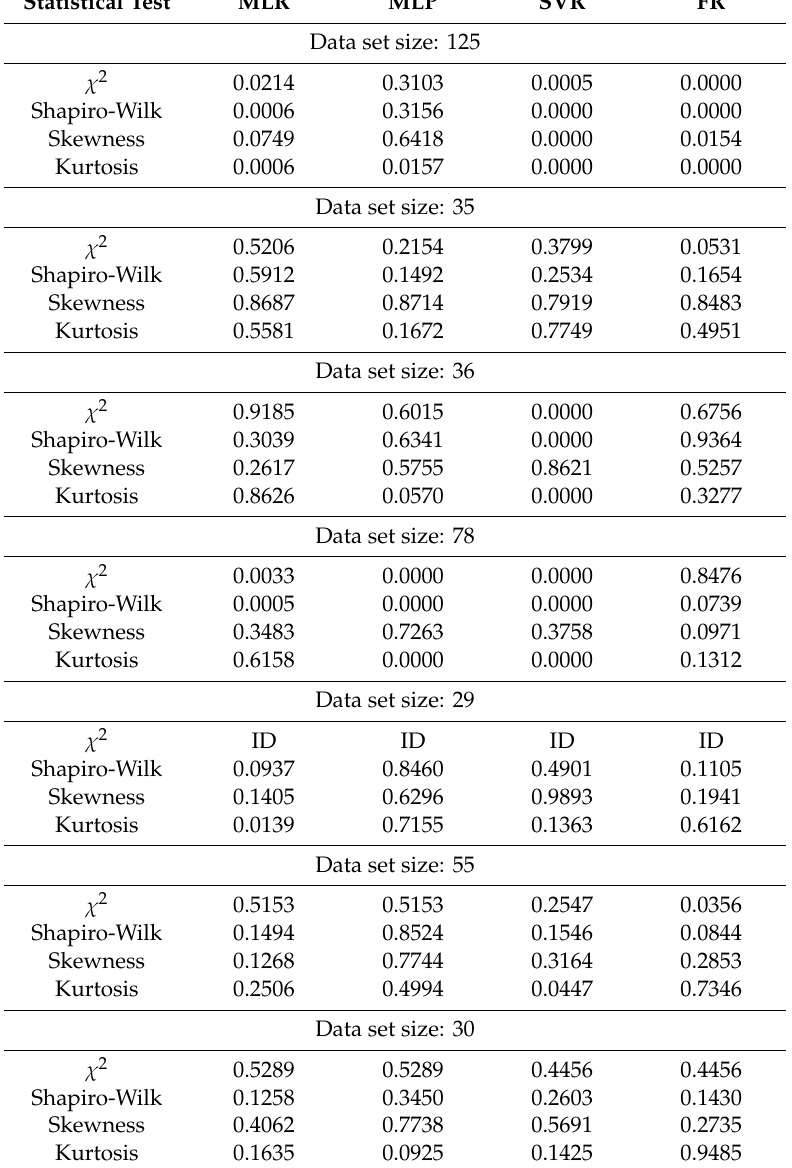
Table 7. p -value by data set after applying the corresponding normality statistical test obtained from a data set of di ff erences of absolute residuals (ARs) between search method based on feature construction (SMFC) and each model (ID: insu ffi cient